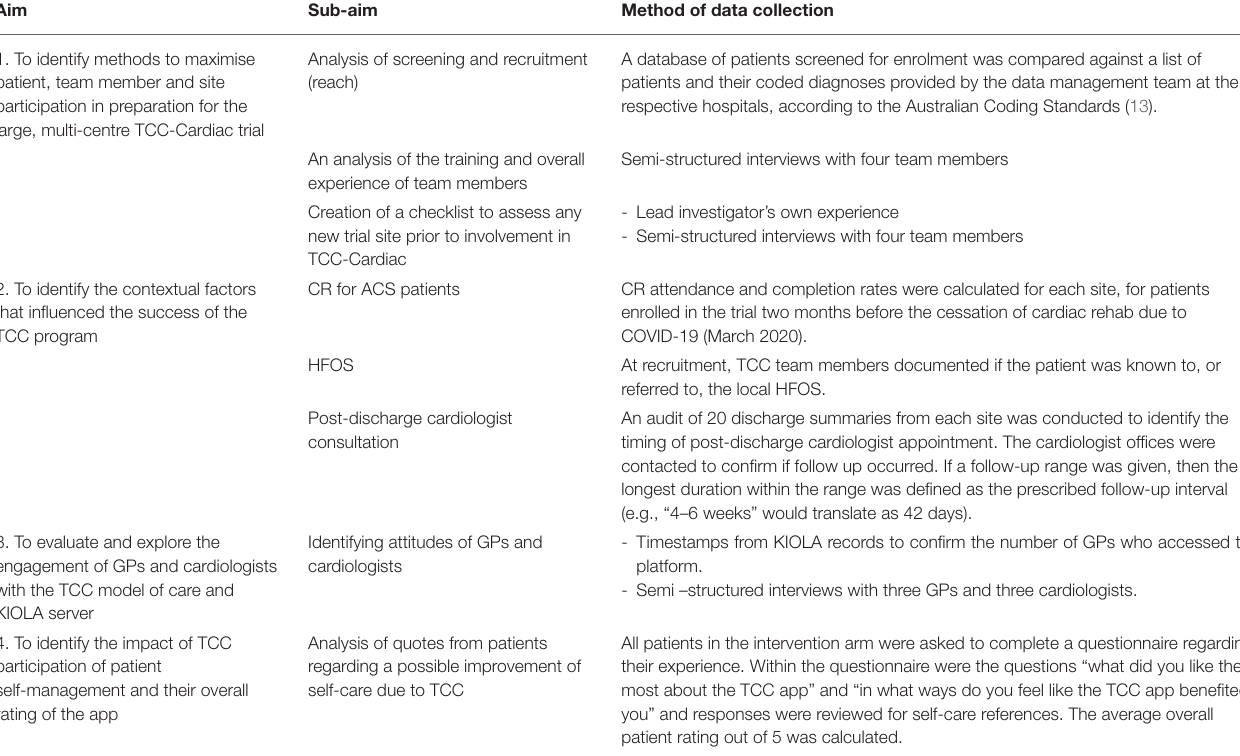
TABLE 1 | Methods utilised in this process